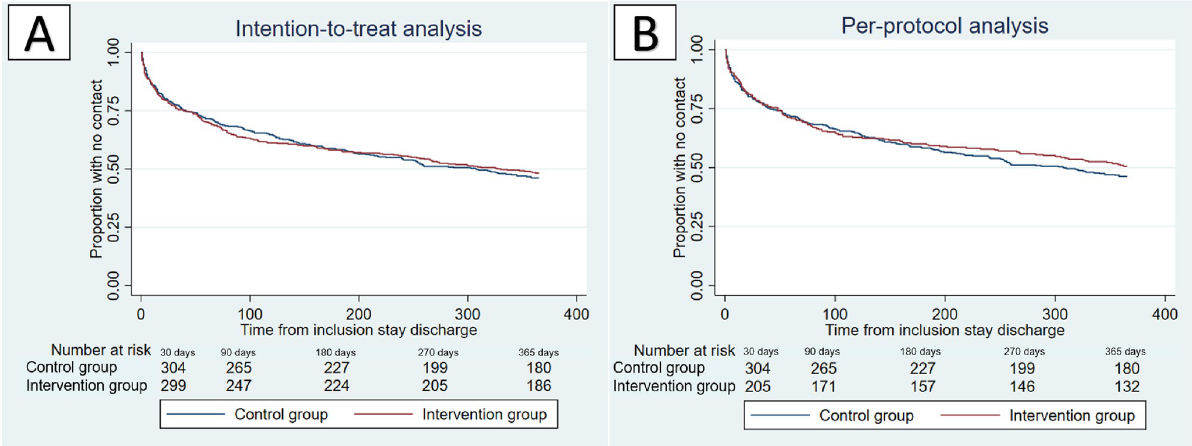
Fig 3. Time to next unplanned contact with hospital (ED-visit or hospital admission). (A) Intention-to-treat analysis of patients with follow-up data, intervention group (n = 394) vs. control group (n = 395) (B) Per-protocol analysis of patients with follow-up data, intervention group (n = 267) vs. control group (n =